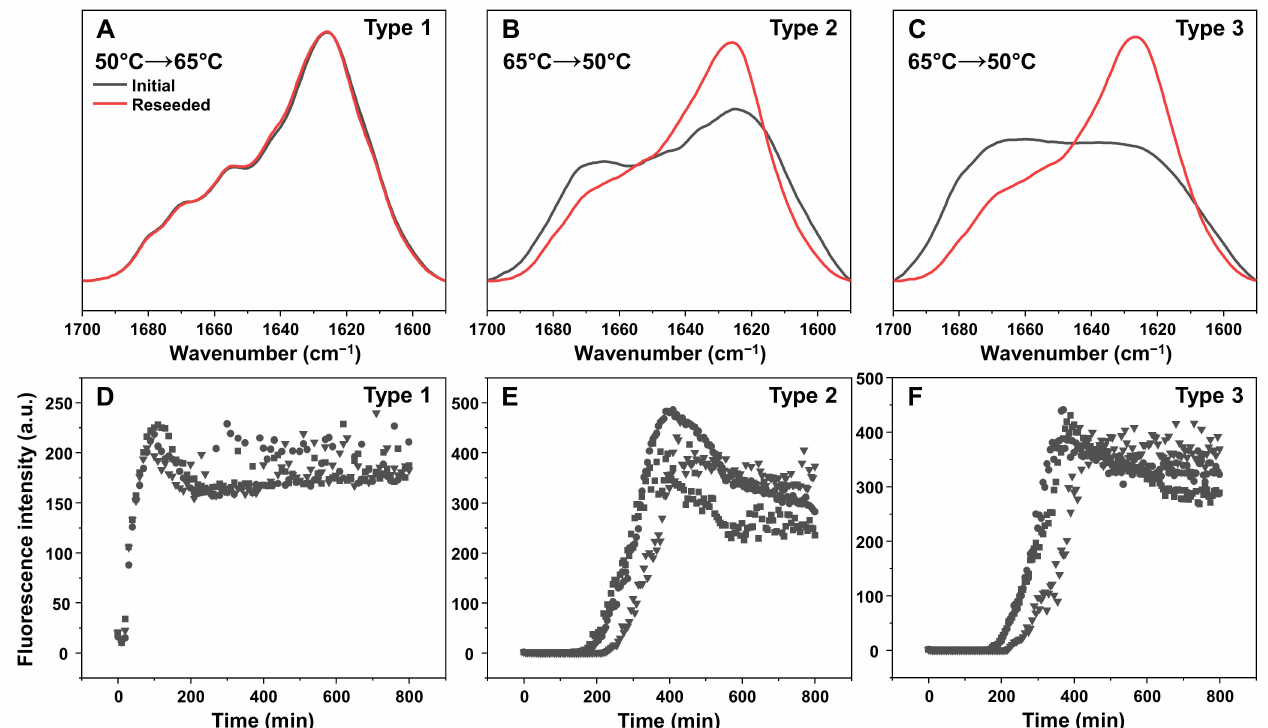
Figure 5. Fourier-transform infrared (FTIR) spectra of Type 1 ( A ), Type 2 ( B ) and Type 3 ( C ) lysozyme aggregates before and after the reseeding reaction and their respective aggregation kinetic curves ( D – F ). The reseeding procedure is described in the Materials and Methods section. Kinetic curves are from three repeats (different symbols represent separate samples). Raw data are available in the Supplementary